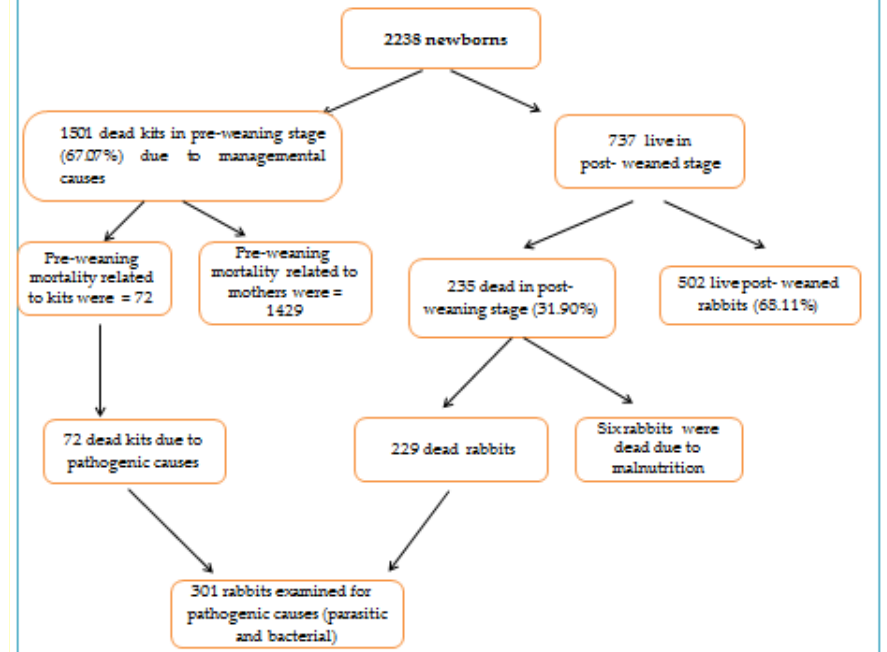
Figure 1. Flow chart showing the causes of newborn deaths in pre-and postweaning stages.